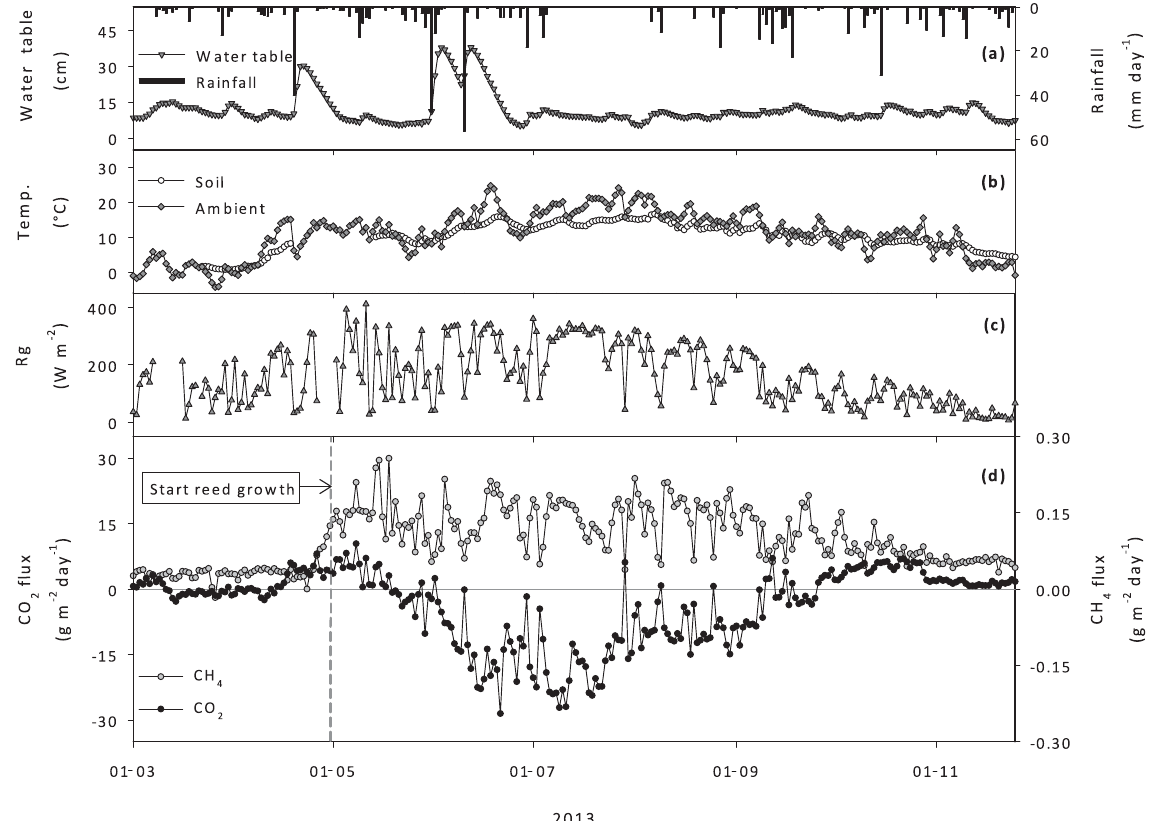
Figure 3. (a) Daily averages of water table and rainfall, (b) soil and ambient temperature, (c) global radiation (Rg) and (d) CO 2 and CH 4 fluxes in the period 1 March–25 November